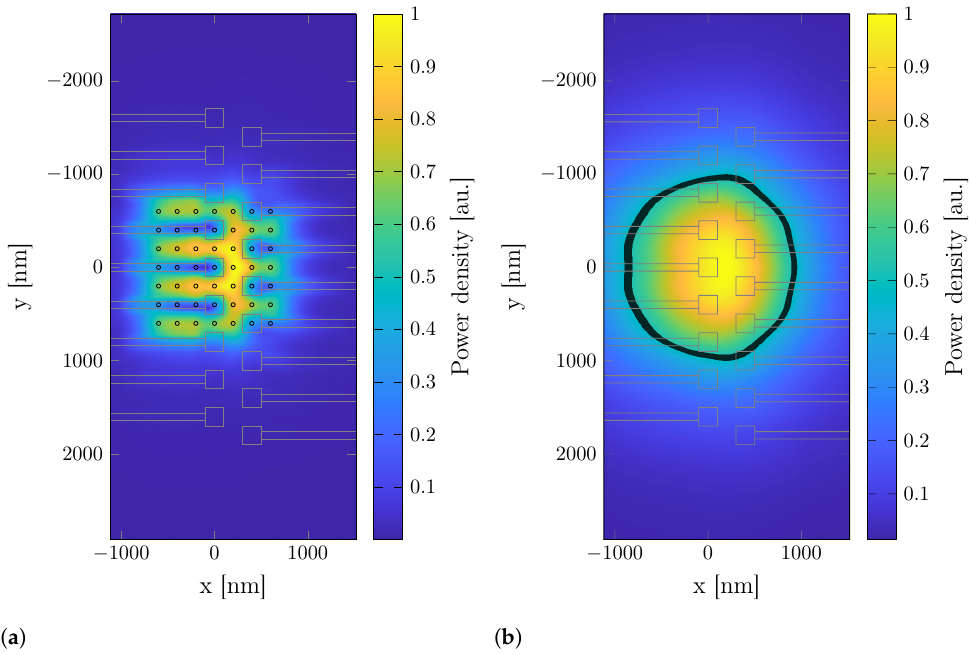
Figure 9. ( a ) Normalized intensity immediately above the double-line LED resulting from emission from a larger area, as an approximation for non-negligible current spreading. The small circles indicate positions of the dipoles. ( b ) Intensity at a distance of 500 nm. The thick black line indicates the isoline at half of the maximum intensity. Contact metallization is